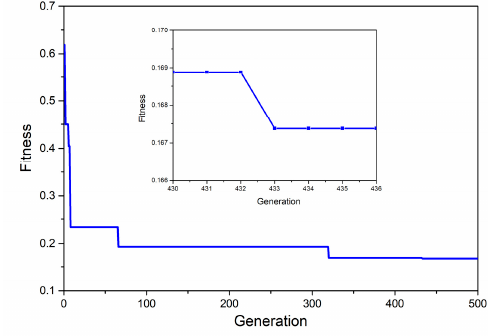
Figure 8. Fitness evolution curve of the thickness of interface delamination.